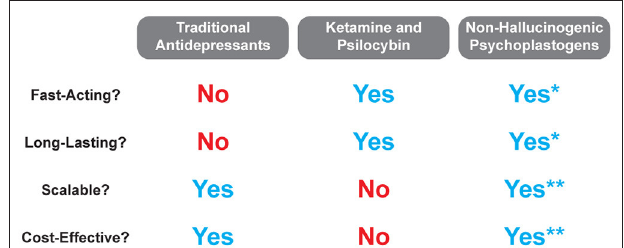
FIGURE 7 | Comparison of traditional antidepressant treatments with hallucinogenic and non-hallucinogenic psychoplastogen treatments. *Currently, no clinical trials have been conducted with non-hallucinogenic psychoplastogens, and thus, their fast-acting and long-lasting effects refer to preclinical testing only. **The scalability and cost-effectiveness of non-hallucinogenic psychoplastogens are based on the assumption that they will produce clinical efficacy greater than the standard of care (i.e., traditional